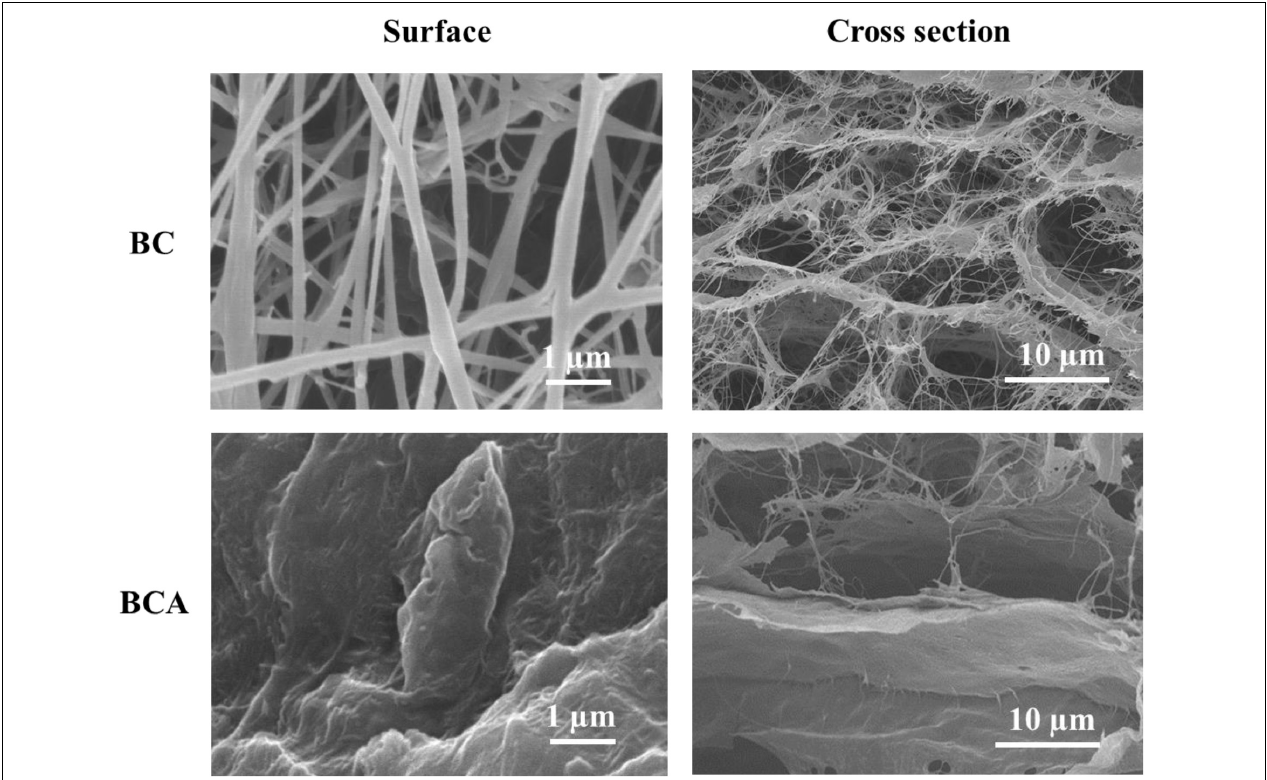
FIGURE 3 | Field-emission scanning electron micrographs of the surface and cross-sectional views of pristine BC and ex situ developed Aloe vera -loaded-BC composite (i.e., BCA) containing 40 wt.% Aloe vera